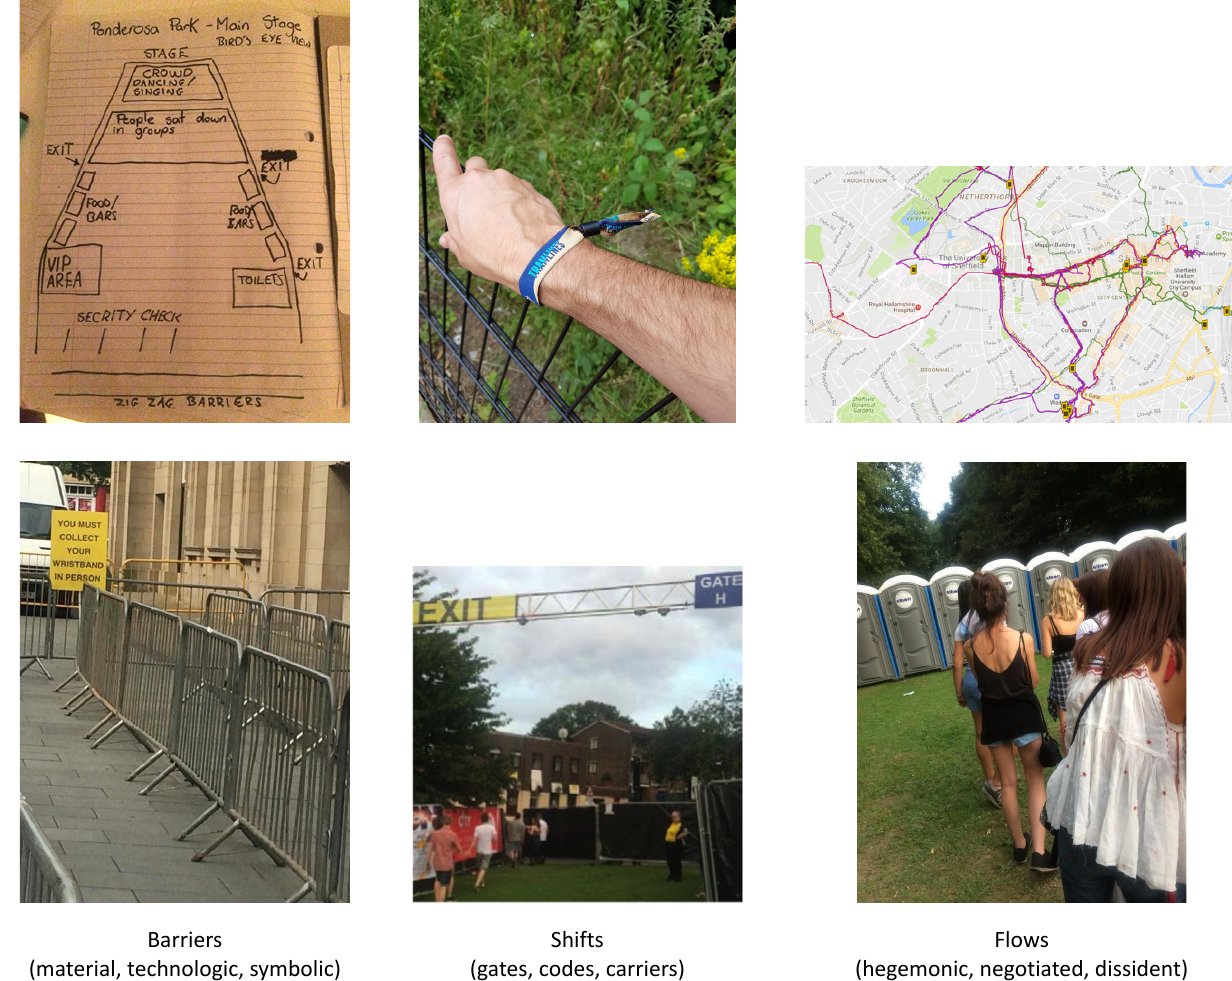
Figure 1. Examples for barriers, shifts, and flows (captured by visual